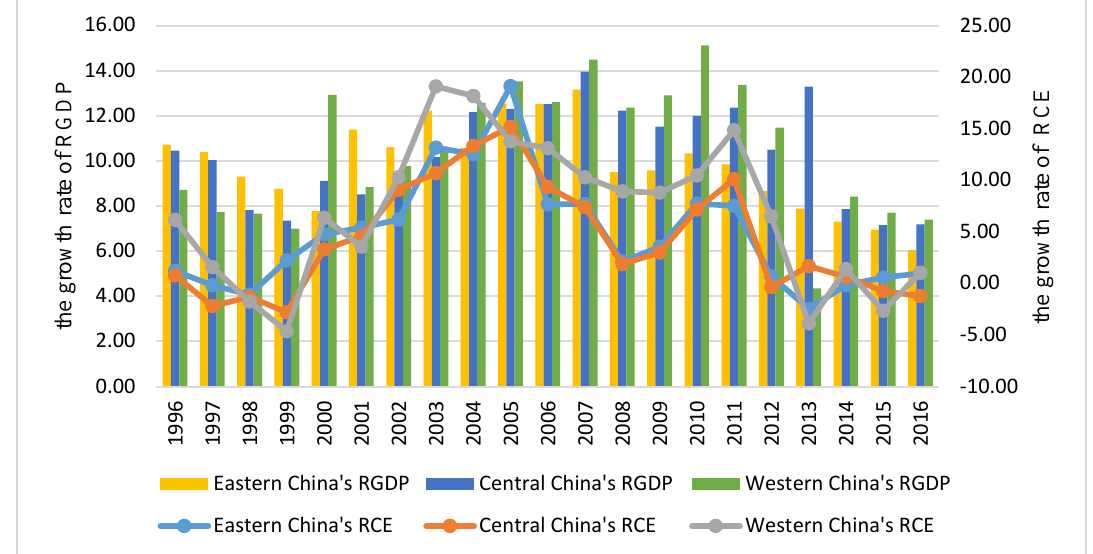
Figure Figure 3. The growth rates of RGDP and RCE in the eastern, central, and western China during 1995– 2016.